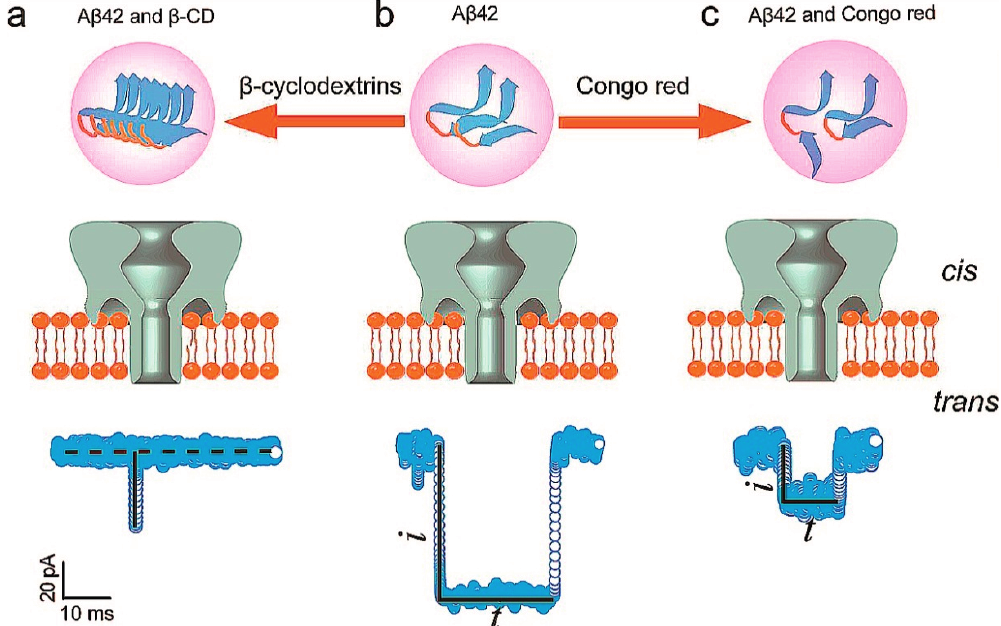
Figure 3. A β 42 was added from the cis chamberin with and without β -cyclodextrin (A β 42-CD) or Congo Red (A β 42-CR), respectively. ( a ) Manifestation of the collision event of A β 42-CD; ( b ) Manifestation of the blockage event of A β 42; ( c ) Manifestation of the blockage event of A β 42-CR. Reproduced with permission from